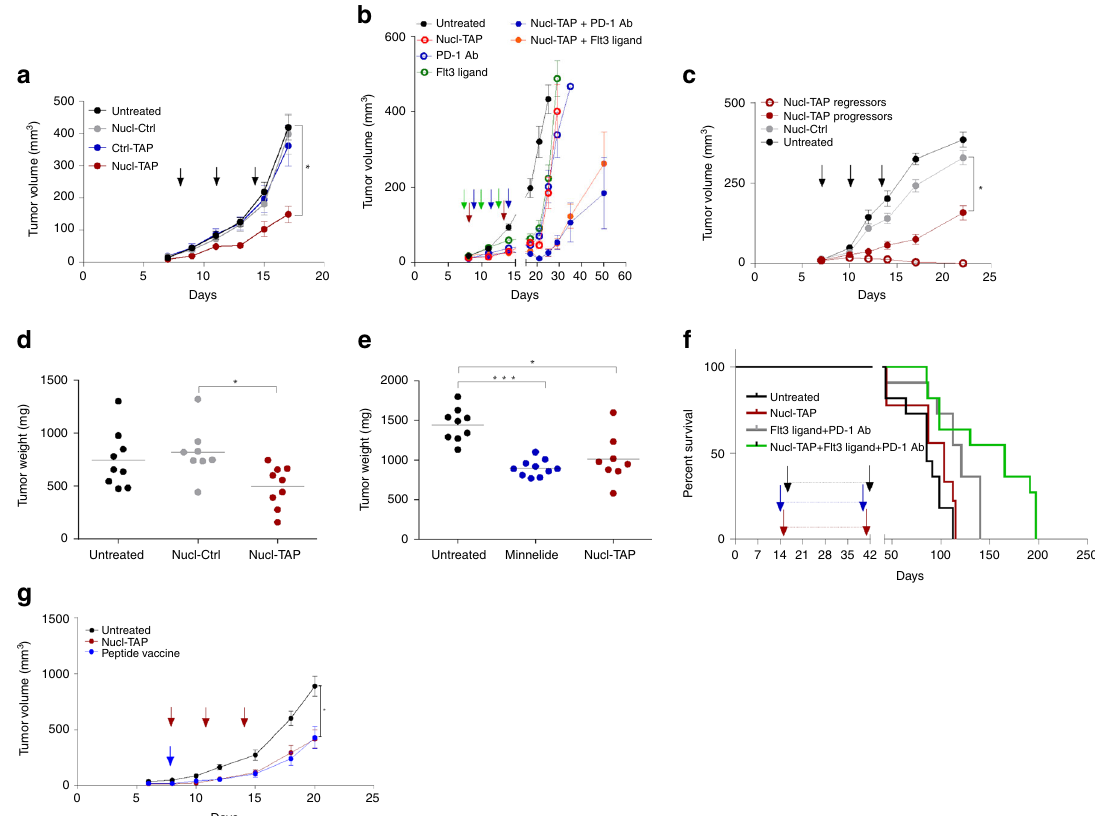
Fig. 3 Nucleolin aptamer-targeted TAP siRNA-mediated inhibition of tumor growth in mice. a 4T1 breast carcinoma model. Arrows: treatment with aptamer-siRNA conjugate (11 mice/group) ( n = 3). b As in panel a except that the 4T1 tumor-bearing mice were treated only twice instead of three times with Nucl-TAP. Where indicated, mice were treated with PD-1 Ab or with Flt3 ligand. Arrows: Nucl-TAP, red; PD-1 Ab, blue or Flt3 ligand, green (9 – 10 mice/group) ( n = 2). Nucl-TAP versus Nucl-TAP + PD-1 Ab, P < 0.0001; PD-1 Ab versus Nucl-TAP + PD-1 Ab, P = 0.0003; Nucl-TAP versus Nucl-TAP + Flt3 ligand, P < 0.0001; Flt3 ligand versus Nucl-TAP + Flt3 ligand, P = 0.0238. c A20 B lymphoma model. Arrows: treatment with aptamer-siRNA conjugates (untreated and Nucl-Ctrl, 7 mice/group; Nucl-TAP, 30 mice/group) ( n = 2). Progressors (19 mice), regressors (11 mice). For a , b , and c , data represent means and SEM . d and e Orthotopic KPC-derived pancreatic cancer model (experimental protocol shown in Supplementary Fig 3c). d Tumor weight 37 days post tumor implantation (8 – 9 mice/group) ( n = 2). e Same as d except for including a group of mice treated with Minnelide (9 – 10 mice/group) ( n = 1). For d and e , each circle represent an individual mouse, and means per group are shown. f BRAF/PTEN melanoma model. Tumor-bearing mice treated with a combination of Nucl-TAP, PD-1 Ab, and Ftl3 ligand. Arrows indicated beginning and end of treatment. Red, Nucl-TAP; black, PD-1 Ab; blue; Flt3 ligand. Untreated versus Nucl-TAP, p = 0.2657; Untreated versus PD-1 Ab + Flt3 ligand, P = 0.1168; Untreated versus combination 3×, p = 0.0067; Nucl-TAP versus combination 3×, P = 0.0133; PD-1 Ab + Flt3 ligand versus combination 3x P = 0.0543 ( n = 1) . g MC38 adenocarcinoma model. MC38 tumor-bearing mice were treated with either Nucl-TAP or a mixture of 3 peptides mixed in adjuvant as described in 21 . Arrows: Nucl-TAP, red; Peptide vaccine, blue. Two experiments performed are shown together (11 – 14 mice/group). Data represent means and SEM. a – c and g statistical analyses using one-way ANOVA test and Tuckey posttest. d and e statistical analyses using Kruskal – Wallis test and Dunn posttest. f Survival curves analyzed by Log-rank (Mantel – Cox) test. a , c , d , e , and g differences are indicated in graphs: *** P < 0.005, * P < in organ weight (Fig. 5a),CD4 + /CD8 + cell ratio in the spleen (Fig. 5b), activation markers of CD4 + and CD8 + T cells (Fig. 5c), hematology parameters (Supplementary Table 1), serum cyto-